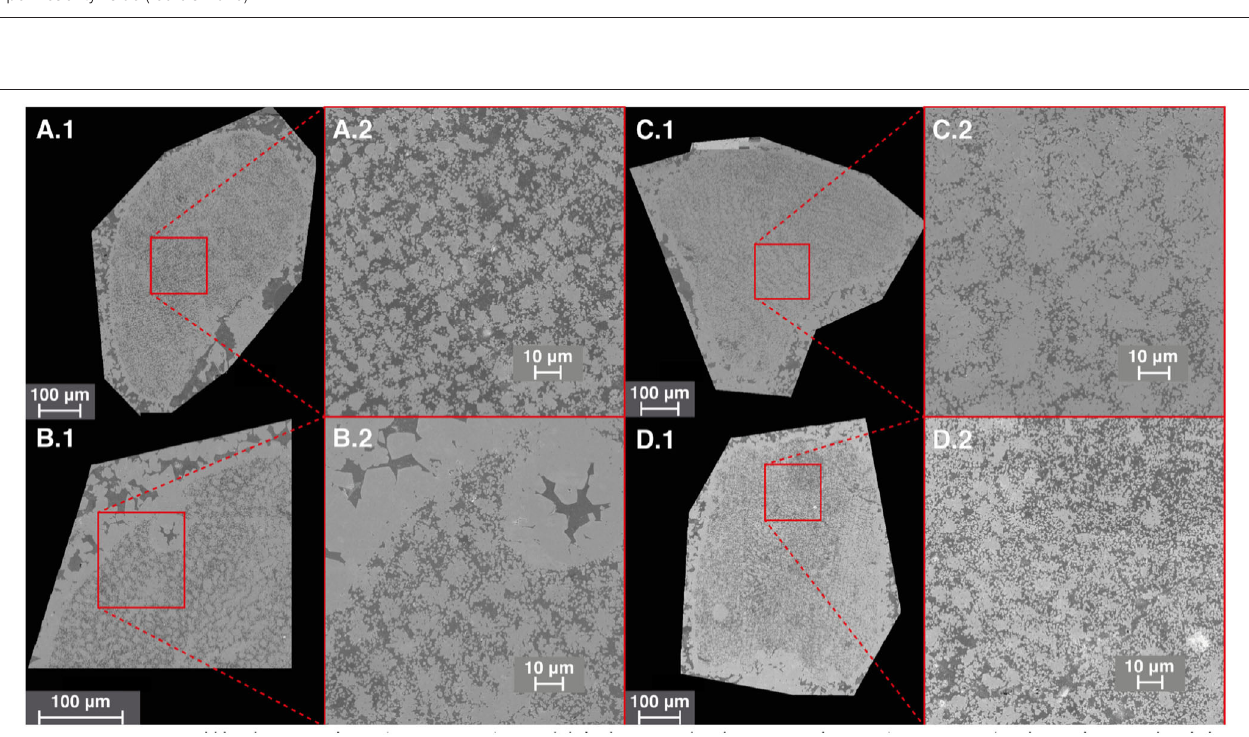
FIGURE 8 | Estaillades grains (A.1–D.1) and high-resolution sections (A.2–D.2) showing micritic calcite with some dense calcite around the grain boundaries.